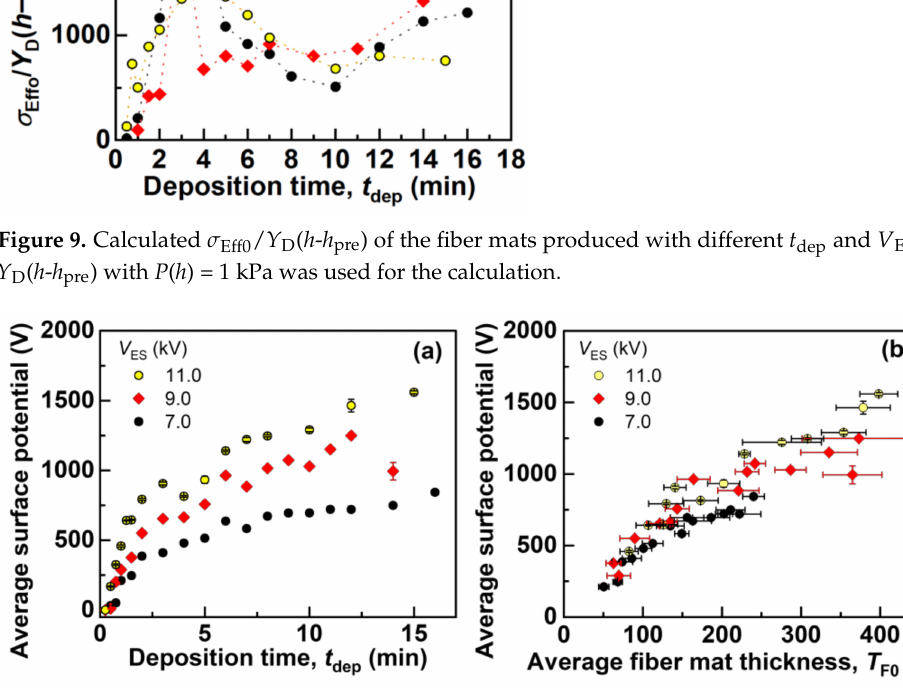
Figure 10. Average surface potential of each fiber mat produced with different t dep and V ES as a func- tion of ( a ) t dep and ( b ) the average fiber mat thickness. The error bars represent standard deviations. Table 2. Ranges of t dep corresponding to Phases I, II, and